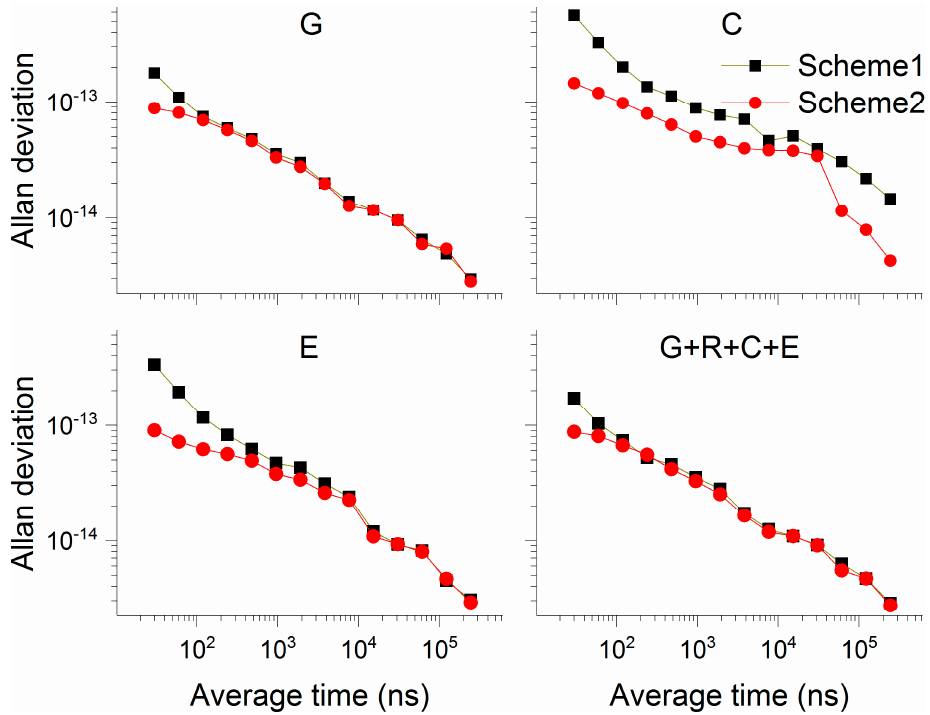
Figure 17. Allan deviation of scheme1 and scheme2 on BRUX-NTSC with single-system and multi-GNSS models using COD products.